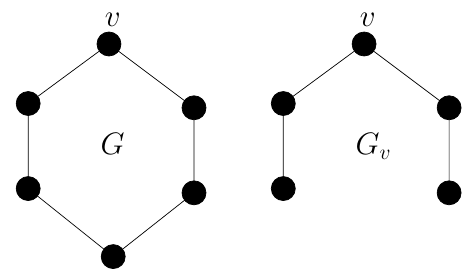
Figure 8 . Construction for the lower bound for a local algorithm for connected dominating set for k = 2